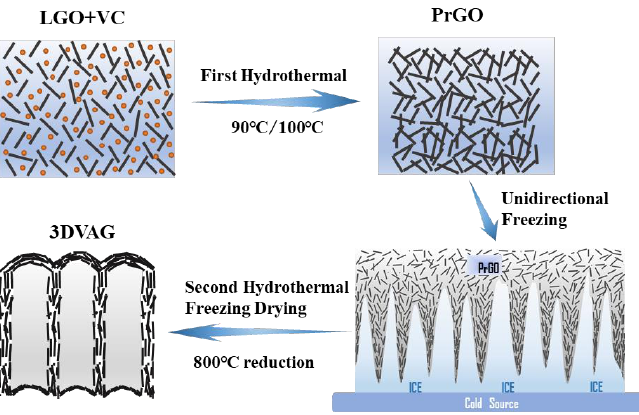
Figure 1. Preparation flowchart of 3DVAG.